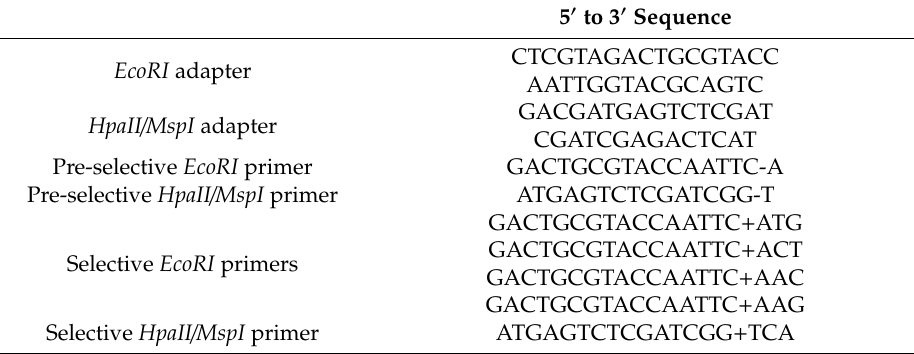
Table 1. Adapters and primers used for the MSAP